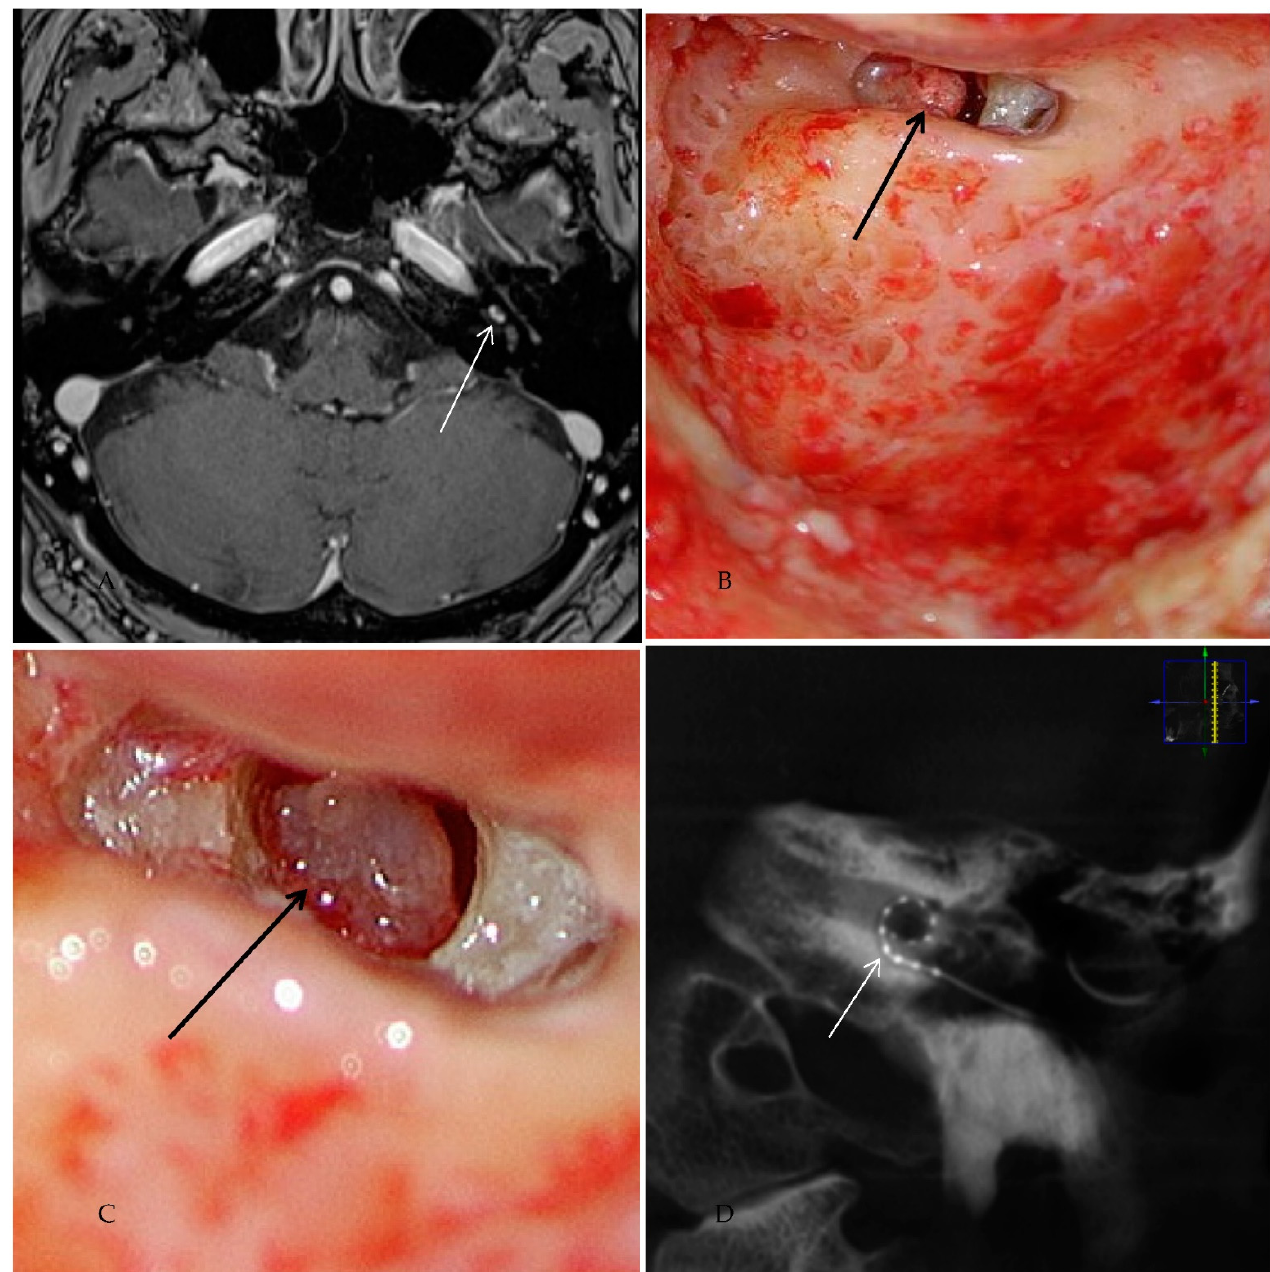
Figure 3. Case #3: ILS of the middle cochlear turn ( A ) MR image T1 VIBE with i.v. gadolinium: the white arrow points to the intracochlear schwannoma in the middle turn. ( B ) Intraoperative image of the subtotal cochleoectomy exposing the schwannoma (black arrow) in the middle turn. ( C ) Magnified image of the intracochlear schwannoma in the middle turn (black arrow). ( D ) Postoperative ConeBeam CT of the CI electrode (white arrow) in the cochlea.